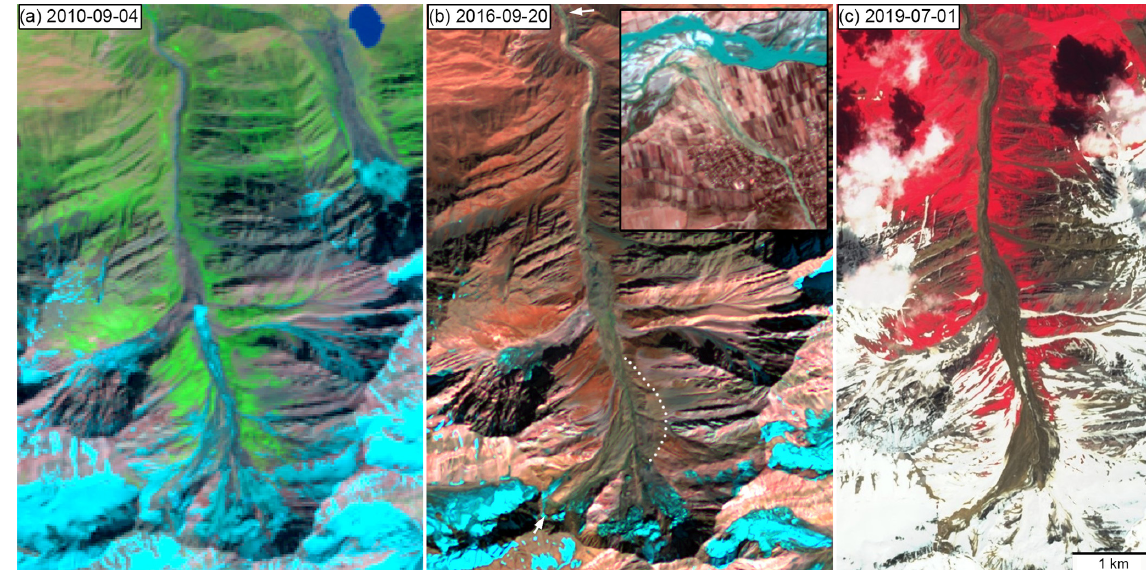
Figure A3. Mass flow events in the western Shuraki Kapali sub-catchment (continued from Fig. A2). (a) L5 image of the sk-10 rock-ice avalanche (4 September 2010); (b) L8 image of the sk-16b rock-ice avalanche (20 September 2016). The trim line of the event is indicated by dots. The arrow in the western part of the catchment indicates where the rock/ice mass detached; the arrow in the downstream valley shows where trees were removed by the resulting mass flow. The inset shows the alluvial fan 19km downstream where a mudflow reached the Surkhob river. (c) S2 image of the sk-19 rock-ice avalanche (1 July 2019). ASTER and L8 imagery courtesy of the US Geological Survey. Copernicus Sentinel data (2020).